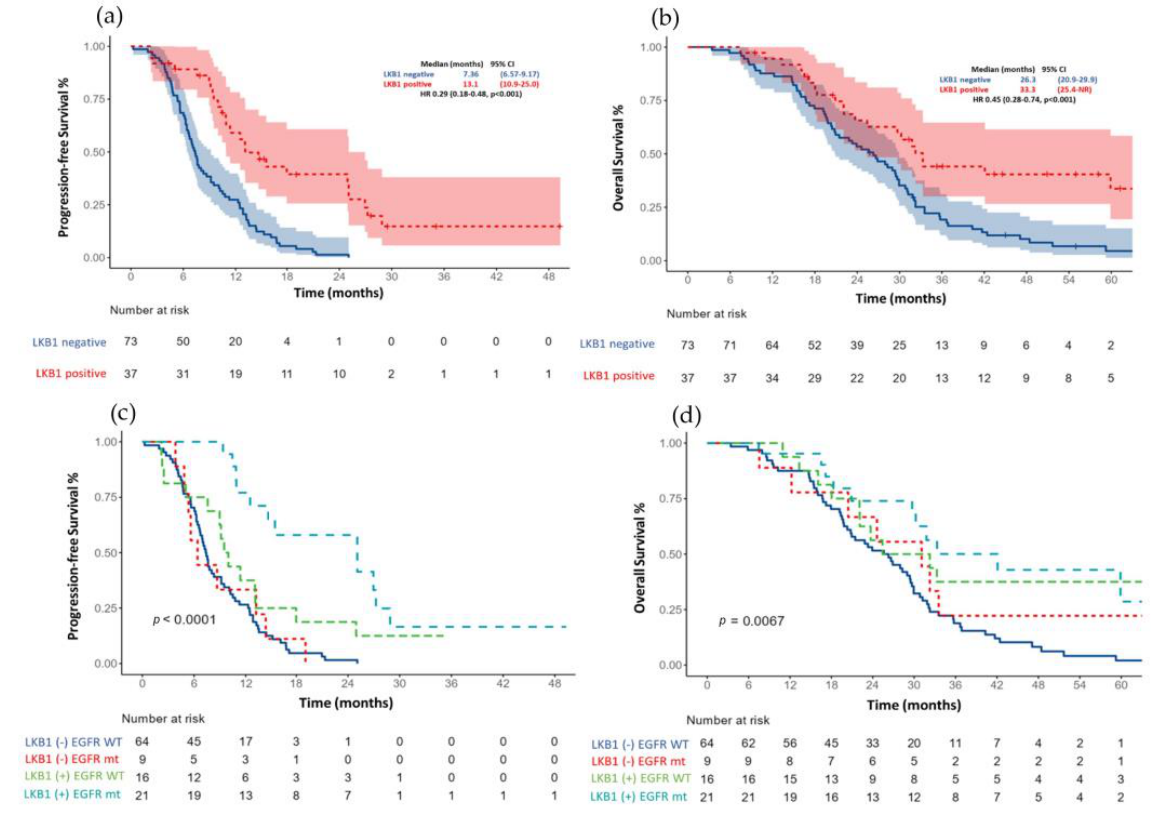
Figure 3. ( a ) Progression free survival based on LKB1 expression and ( c ) after adjustment for EGFR status. ( b ) Overall survival according to LKB1 expression and ( d ) after adjustment for EGFR status. In the univariate analysis, the other factors associated with a worse PFS were the ECOG PS (2), clinical stage IV, EGFR wild-type status and the lack of response to